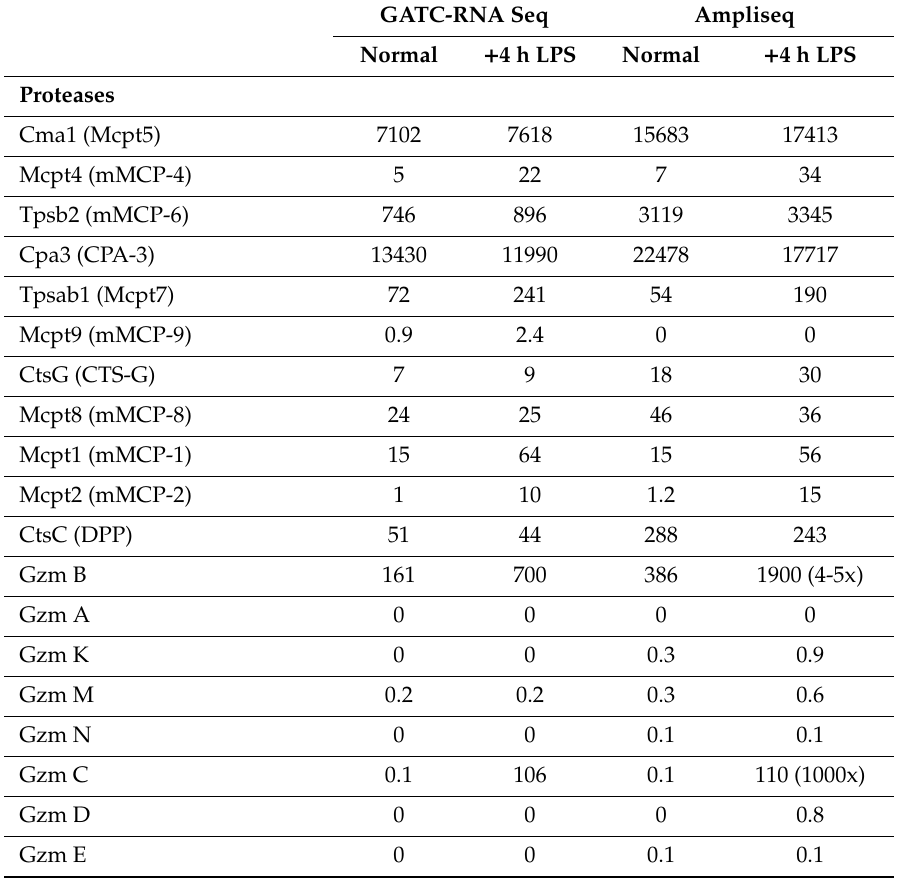
Table 2. Transcript levels for granule proteases, cell surface receptors, and enzymes involved in the production and processing of the granule components in mouse bone marrow-derived MCs (BMMCs; in vitro di ff erentiated; from BALB / c mice). The number of normalized reads for the proteases is given in actual numbers (obtained from GATC biotech and SciLife Thermo Fisher Ampliseq analyses). Two di ff erent growth conditions were tested: unstimulated and stimulated by 1 µ g / mL of lipopolysaccharide (LPS) for 4 h. The fold increases in expression levels (for Gzm B and Gzm C) after LPS stimulation and the levels (in %) of the Fc ε RI alpha chain expression compared to Cpa3 are marked in